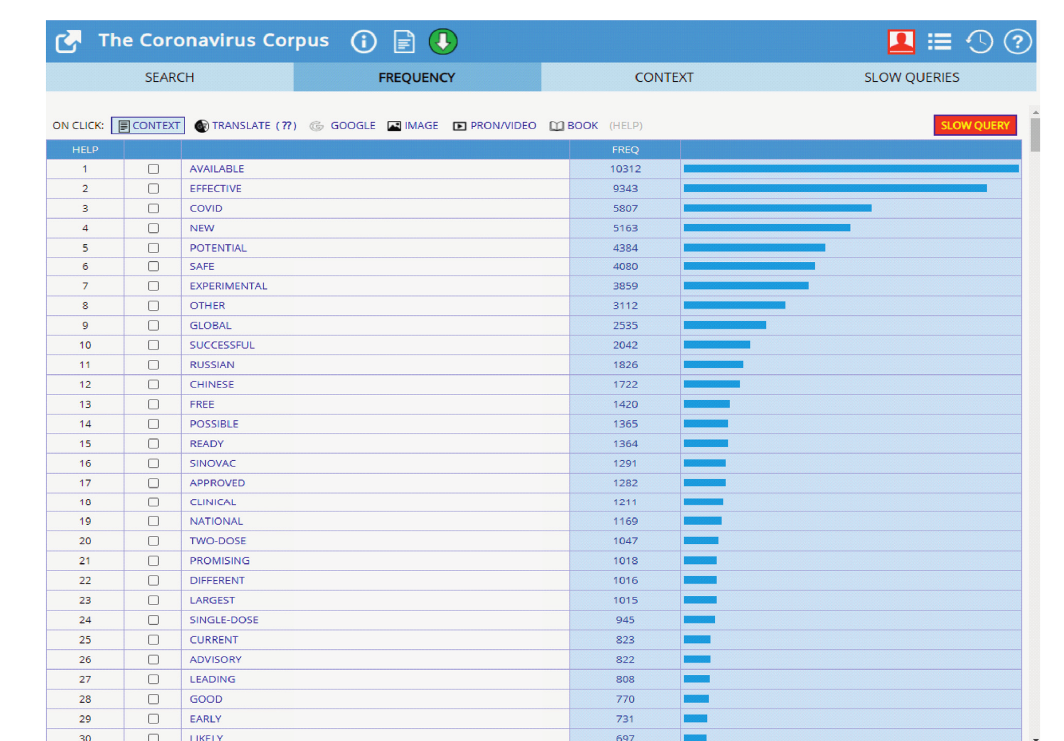
Figure 3: The collocation list in The Coronavirus Corpus